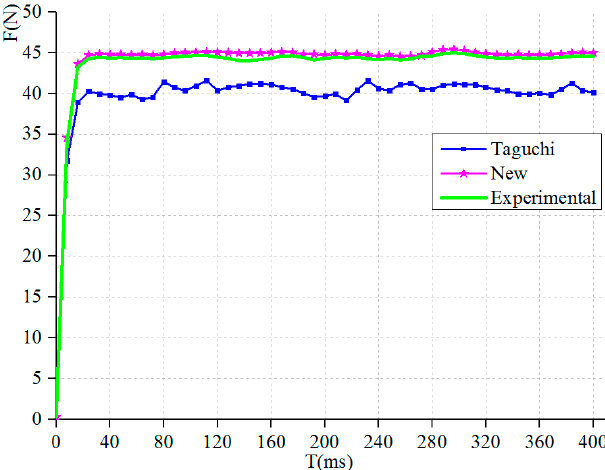
Figure 13. Comparison of motor thrust.